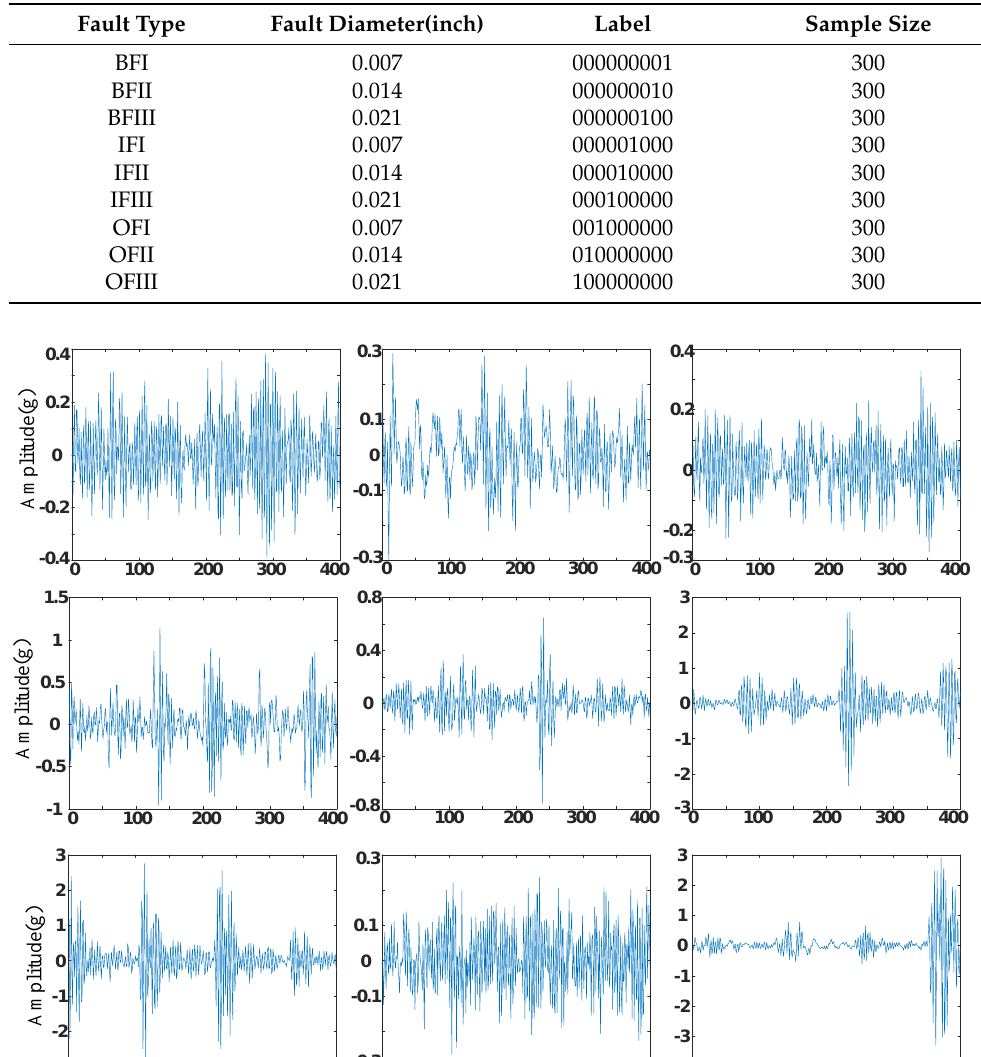
Table 4. Comparison of diagnostic accuracy of different methods.